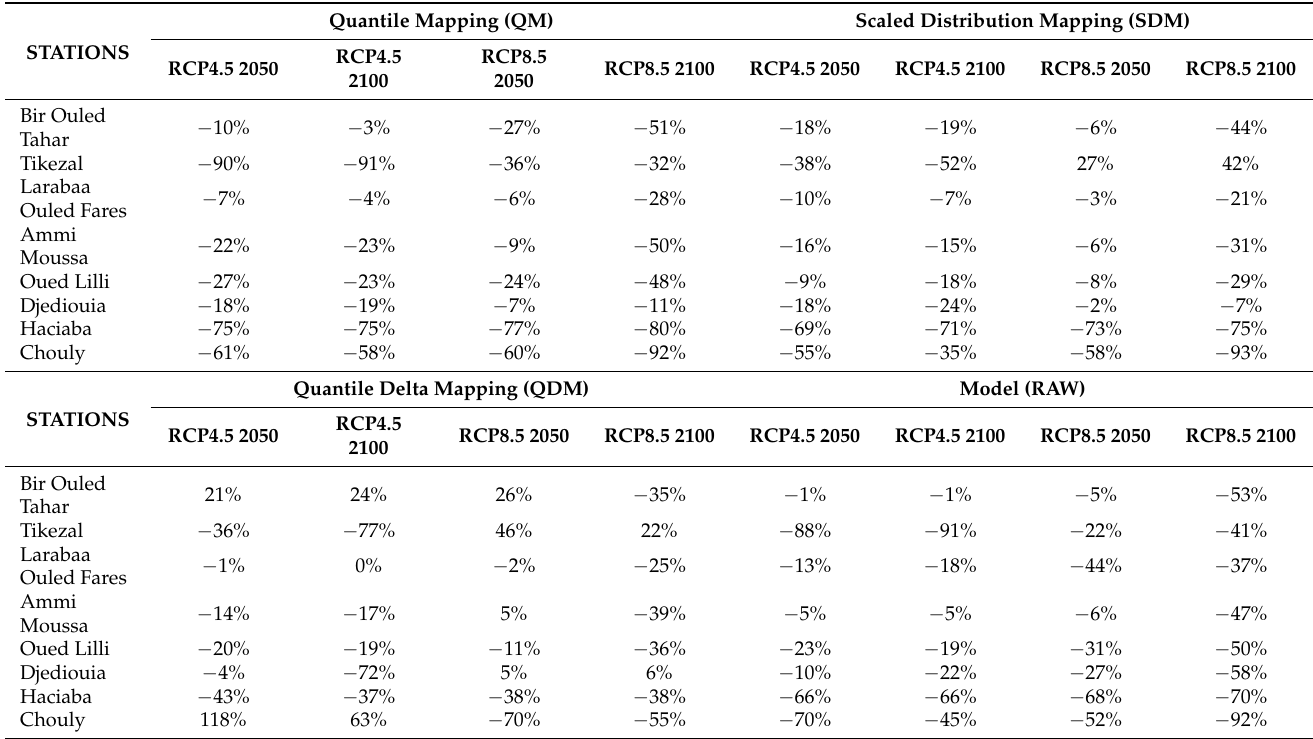
Table 6. Annual streamflow mean changes in the CMT basins from the baseline period